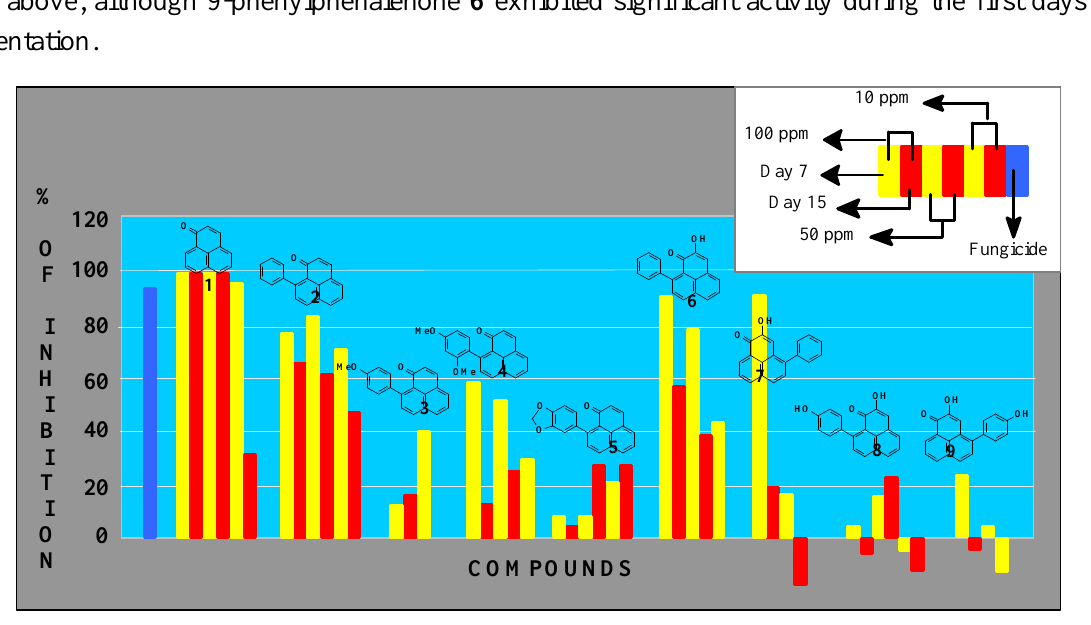
Figure 2. Antifungal activity on M. fijiensis growth (mycelial weight).